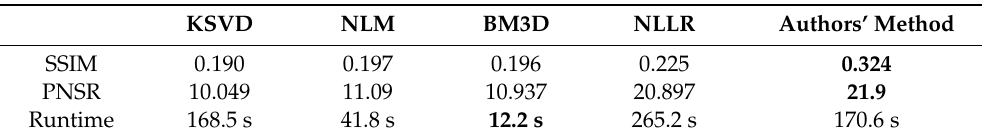
Table 2. Comparison of the different denoising methods applied in Figure 14i. Bold highlights indicate the best results.